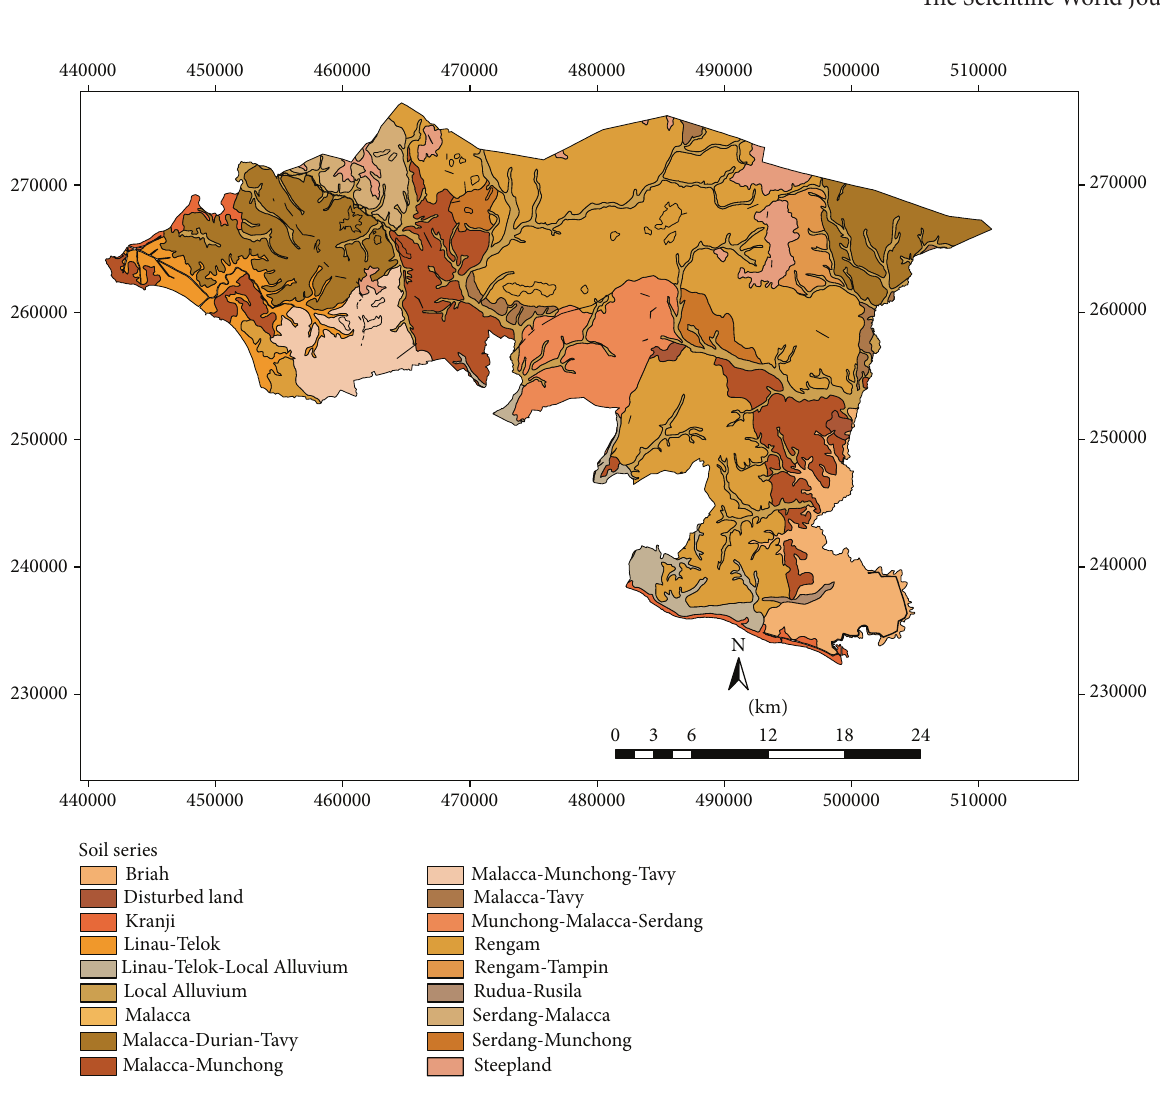
Figure 3: Soil series map of